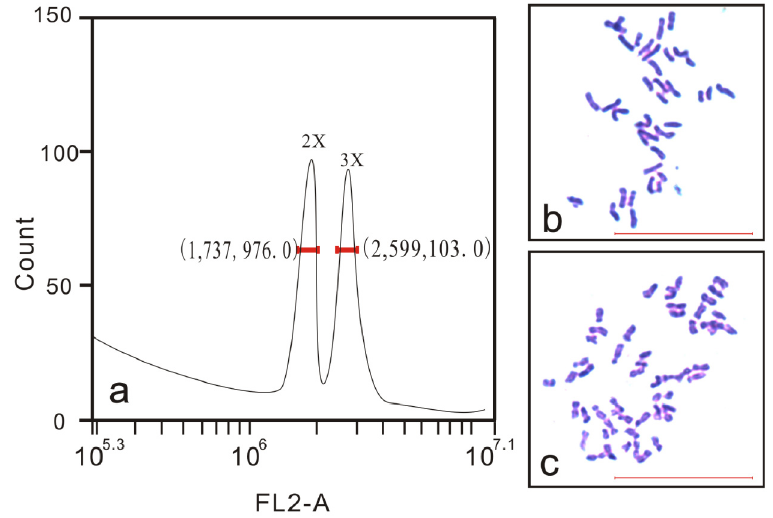
Figure 1. Ploidy level detection of offspring derived from GT1. ( a ) Flow cytometric analysis of diploid and triploid; ( b ) Chromosome number of diploid (2 n = 2 x = 36); ( c ) Chromosome number of triploid (2 n = 3 x = 54). Scale Bar = 50 μ m.